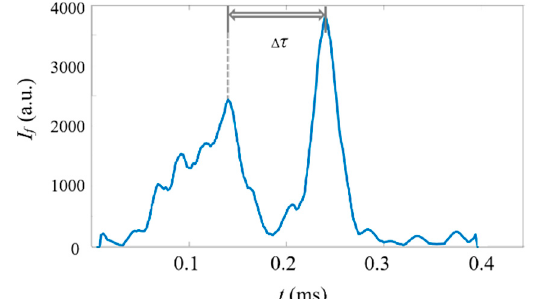
Figure 15. Typical time traces of fluorescence signals of micropillars in a concentration of 2 × 10 8 mL − 1 . Q s = Q j = 20 µ L/h. The horizontal axis represents the time and the vertical axis represents the signal intensity. ∆ τ = 0.1